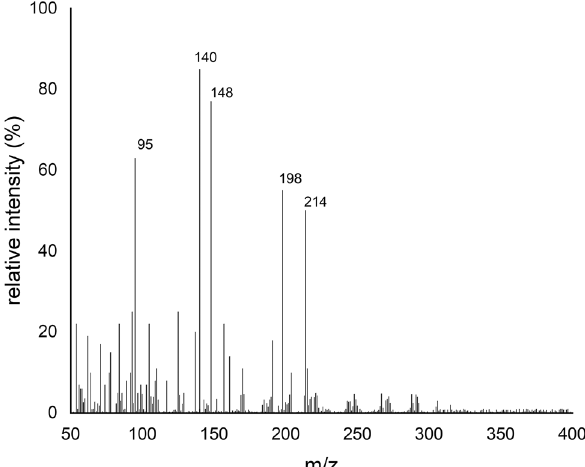
= 50 mg/L, [PDS] = 6 mM, 0 0